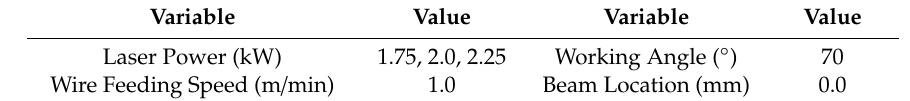
Table 6. Welding conditions of Step 2 (laser power change, 3 cases).